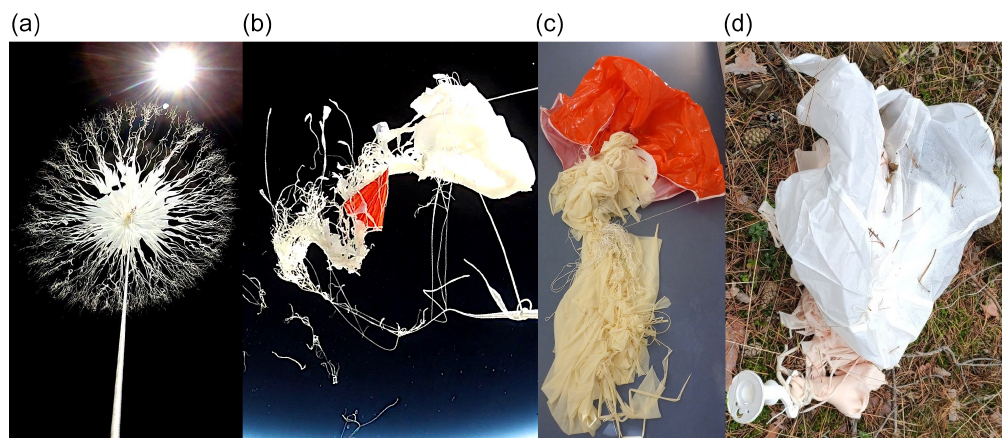
Figure 3. Photographs of (a) a bursting balloon and (b) a parachute (orange) entangled in balloon remains. (c, d) Two images of the balloon remains and parachutes (orange/white) after the descents. These images are for frost point hygrometer launches from Lindenberg; thus, they used larger balloons than a regular radiosonde